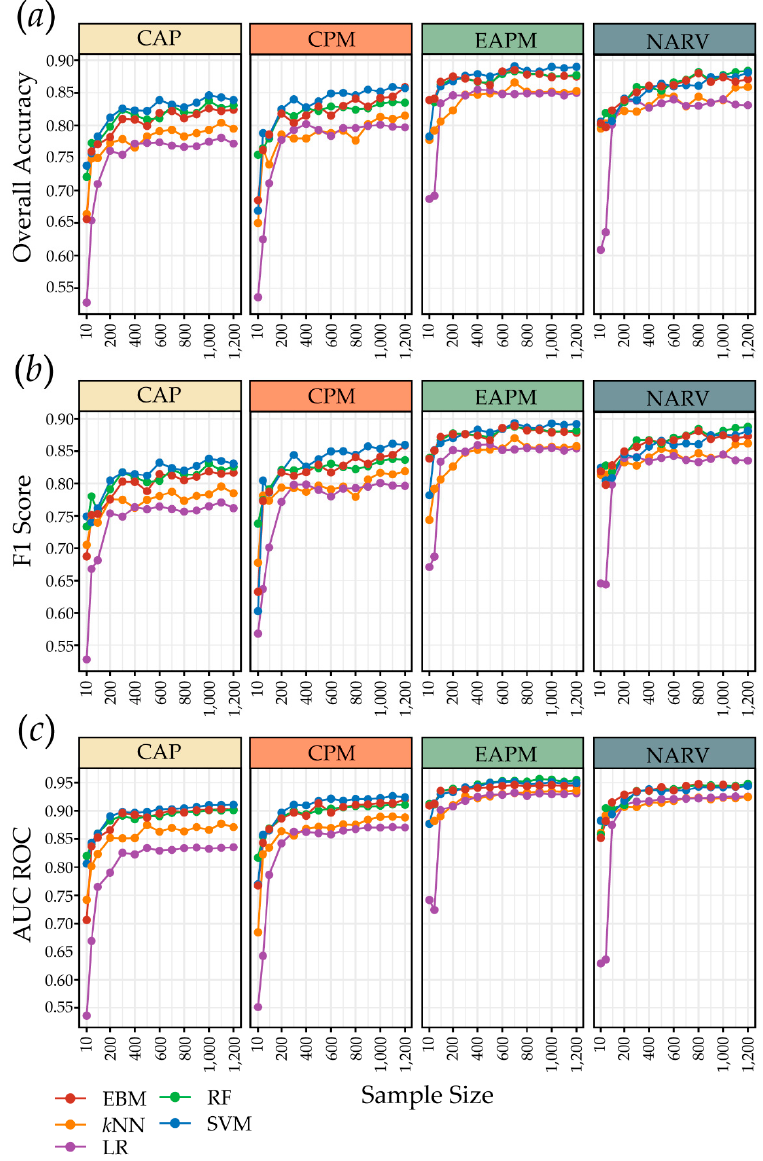
Figure 7. Impact of training sample size on model performance measured using OA, F1 score for the slope failure class, and AUC ROC within all MLRA study areas using all algorithms. Sample size represents the number of samples per class. ( a ) Overall accuracy; ( b ) F1 score; ( c ) AUC ROC.